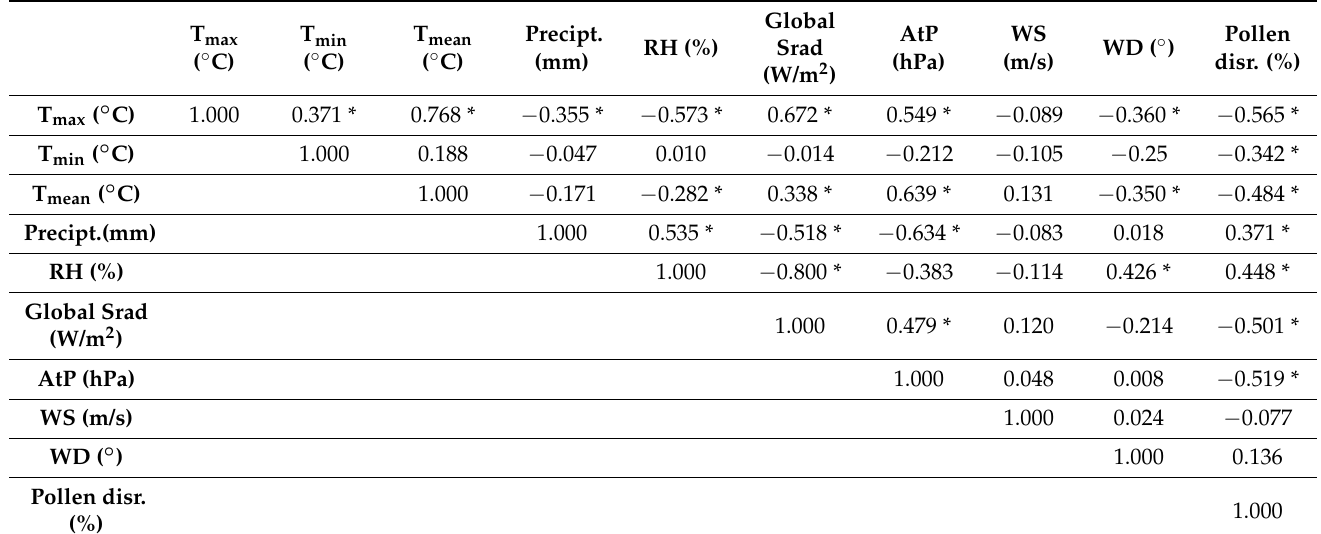
Figure 3. Daily meteorological parameters and daily pollen concentration (DPC), for the period 22 Figure 3. February to 19 March of 2017 and 2018. DPC and rainfall ( a ); daily averaged temperatures (T max , T min , T mean ) and atmospheric pressure ( b ); RH and Global Srad ( c ); and wind speed and direction ( d ). Table 2. Pearson’s correlation between meteorological parameters and pollen disruption in the years 2017 and